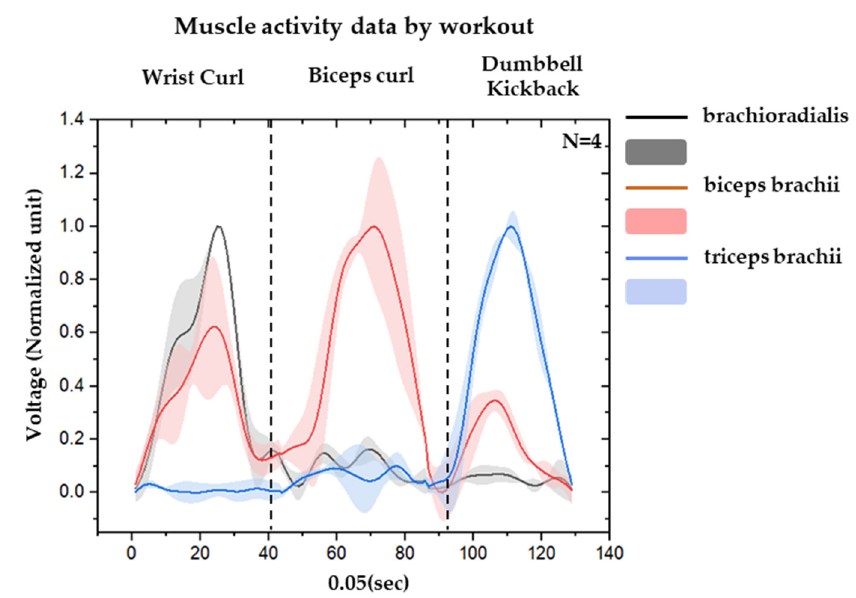
Figure 7. Rescaled EMG data and standard deviation of 4